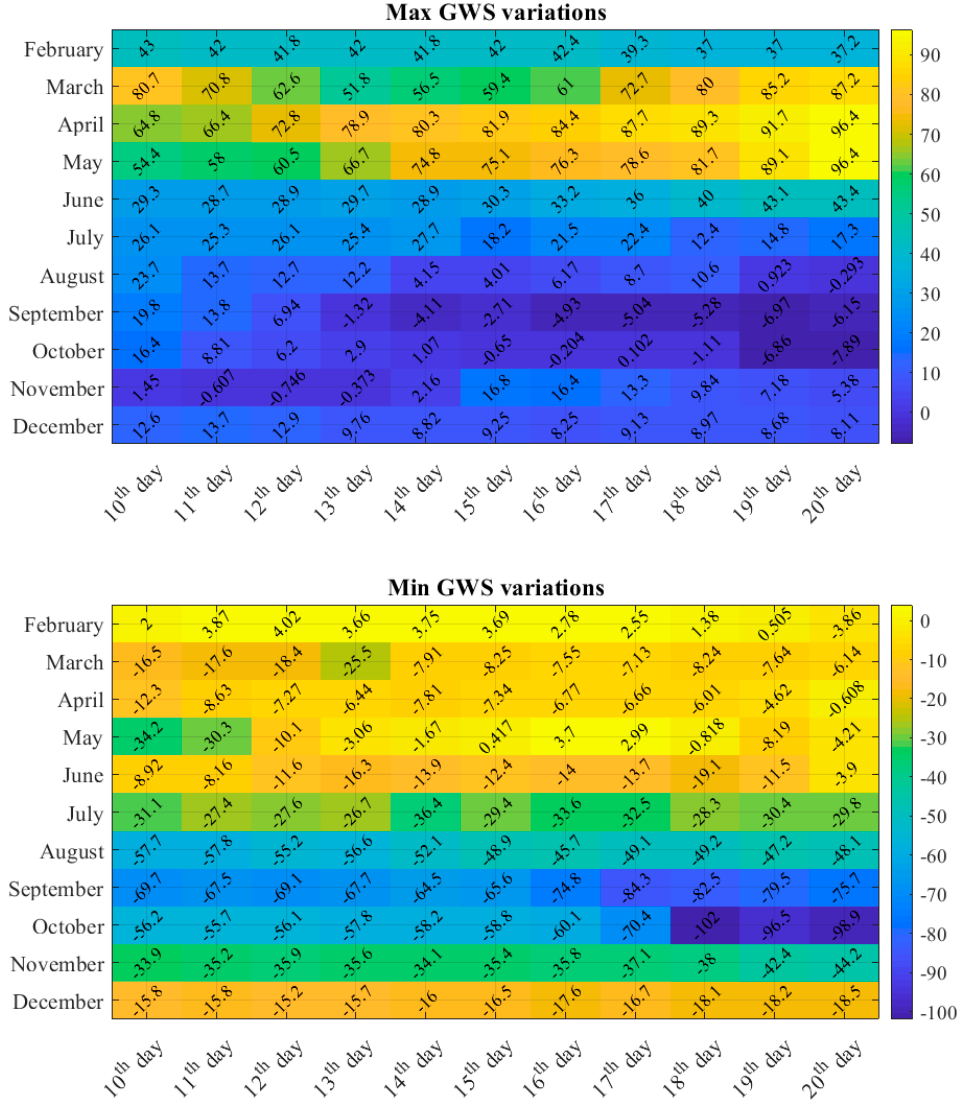
Figure 12. Daily fluctuation of GRACE groundwater storage anomalies (GWSA) in different locations (pixels) after downscaling between the 10th and 20th day of each month between February and December 2003 [mm].